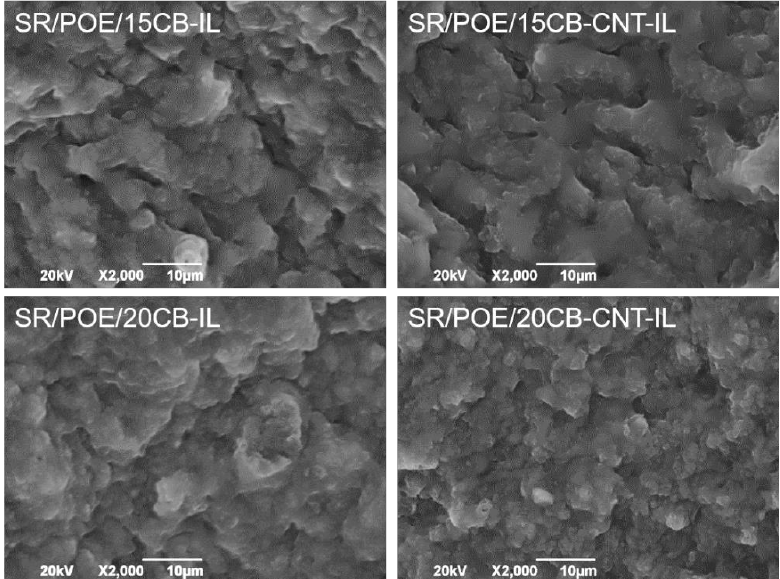
Figure 1. Scanning electron microscopy (SEM) images of the fracture surfaces of the silicone rubber / polyolefin elastomer / carbon black -ionic liquid (SR / POE / CB-IL) and silicone rubber / polyolefin elastomer / carbon black-carbon nanotube-ionic liquid (SR / POE / CB-CNT-IL) composites.